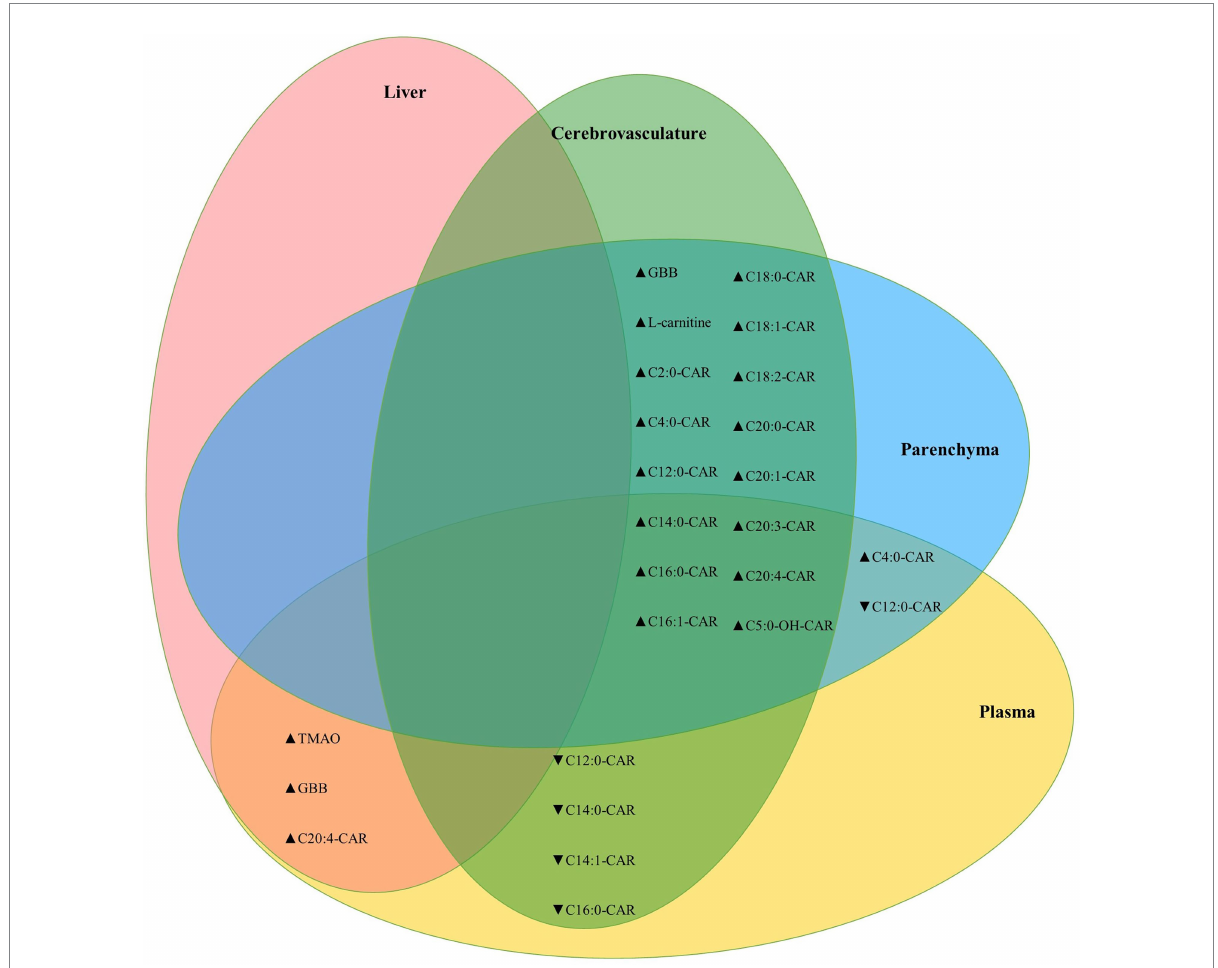
FIGURE 6 Cerebrovascular and brain parenchymal acylcarnitines are highly positively correlated. Venn diagram showing significant correlations between parenchymal, cerebrovascular, plasma, and liver L-carnitine, GBB, and acylcarnitines. The TMAO metabolite was also correlated between plasma and brain homogenate (Kendall’s tau-b = 0.386, p = 7.6E-5) and between brain homogenate and liver (Kendall’s tau-b = 0.383, p = 8.7E-5). Statistics: Kendall’s tau-b with two-tailed significance threshold p < 0.05, ▲ : positive correlation, ▼ : negative correlation. Cx:y-CAR, acylcarnitines; Cx:y- OH-CAR, hydroxy acylcarnitines; GBB, γ -butyrobetaine; TMAO,